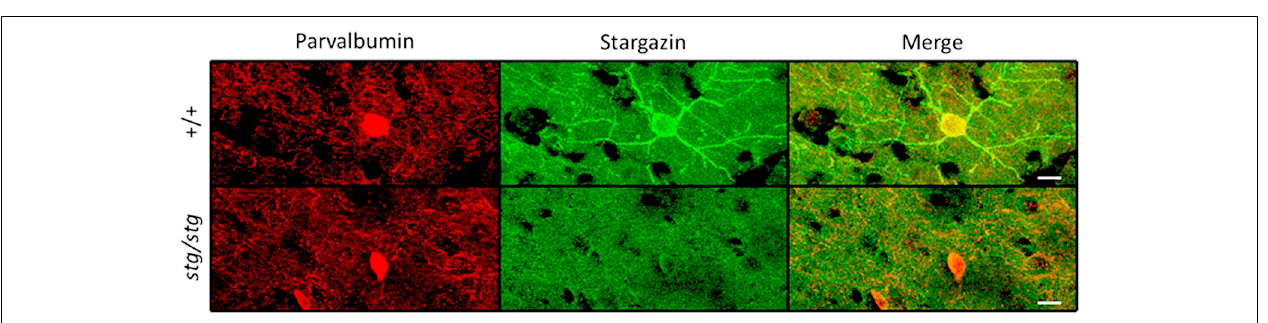
compared to stargazer 0.5 mg/kg). A dose of 0.1 mg/kg was ineffective in stargazer mutant mice. Baseline seizure duration was obtained by summing burst durations over 30 min of acclimatized EEG recording. (B) Representative EEG traces at baseline and 1 h post-injection.